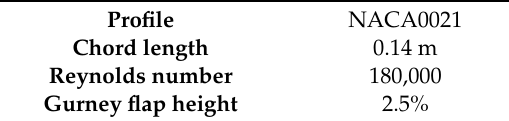
Figure 3. GF configurations: ( A ) one-side GF; ( B ) fish tail GF.